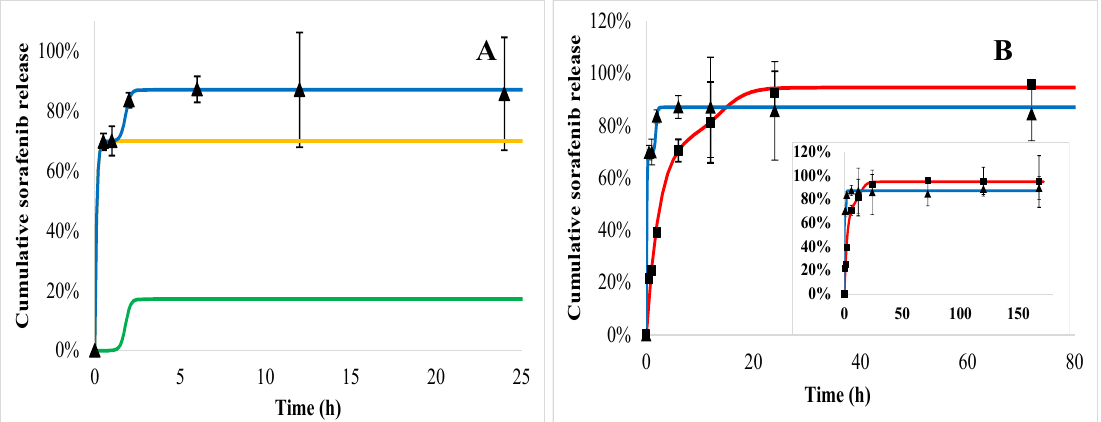
Figure 10. Sorafenib cumulative release from PEGylated PHB nanoparticles measured in blood plasma (trigons) and acid (squares). The fitted release profiles in plasma (blue) and in acid (red) are also drawn. The modeled release profiles are shown as follows: the release kinetics in acid ( A ) was built from the initial burst (yellow line) and polymer degradation (green line). In the insert ( B ), the measured data and the fitted release profiles can be seen on the whole time scale. Table 2. Kinetic parameters of the drug release mechanisms, where ‘n’ is the di ff usion exponent, ‘ k b ’ is the initial burst constant, ‘ θ b ’ is the contribution of initial burst release over total mass drug release, ‘ k r ’ is the rate of the degradation–relaxation constant, ‘ k d ’ is the di ff usion kinetic constant and ‘ t max ’ is the time to achieve a maximum rate of drug release derived from polymer